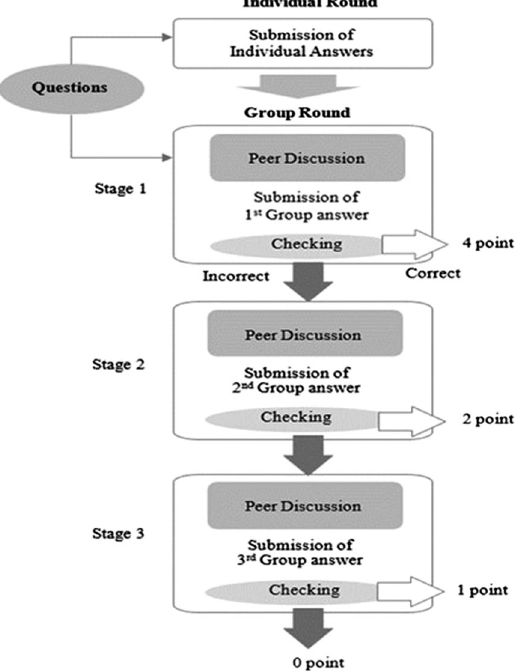
FIG. 1. Process of two-round collaborative exams, RAA. 4 – 5 students who submitted individual-round responses form a group, conduct group discussion, and then submit group-round re- sponses. The group that fails to submit the correct answer in the first attempt of the group round gets two additional